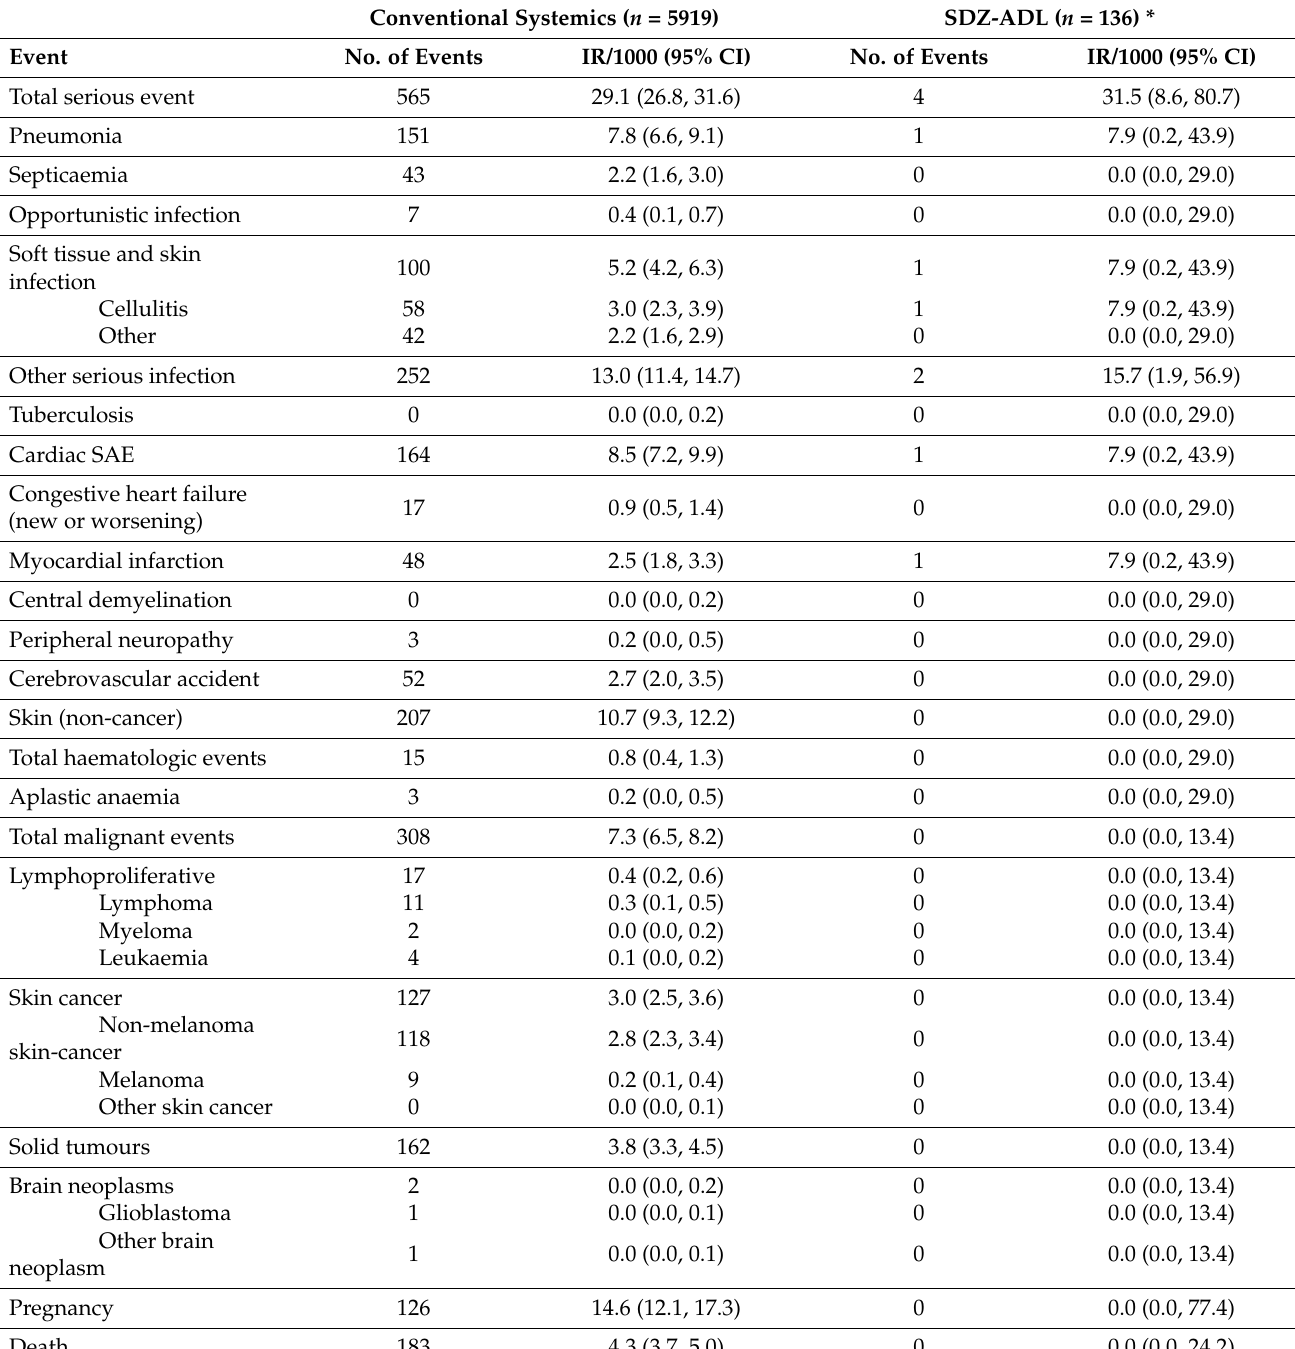
Table 3. Safety data from the safety set.